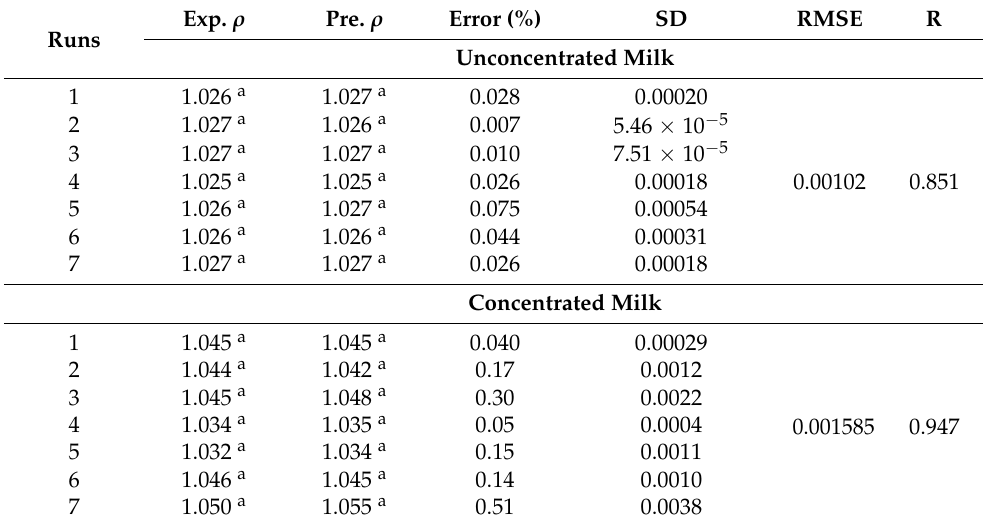
Table 4. Statistical parameters of experimental and predicted unconcentrated milk density values affected by color components. Exp. ρ Pre. ρ Error (%) Runs